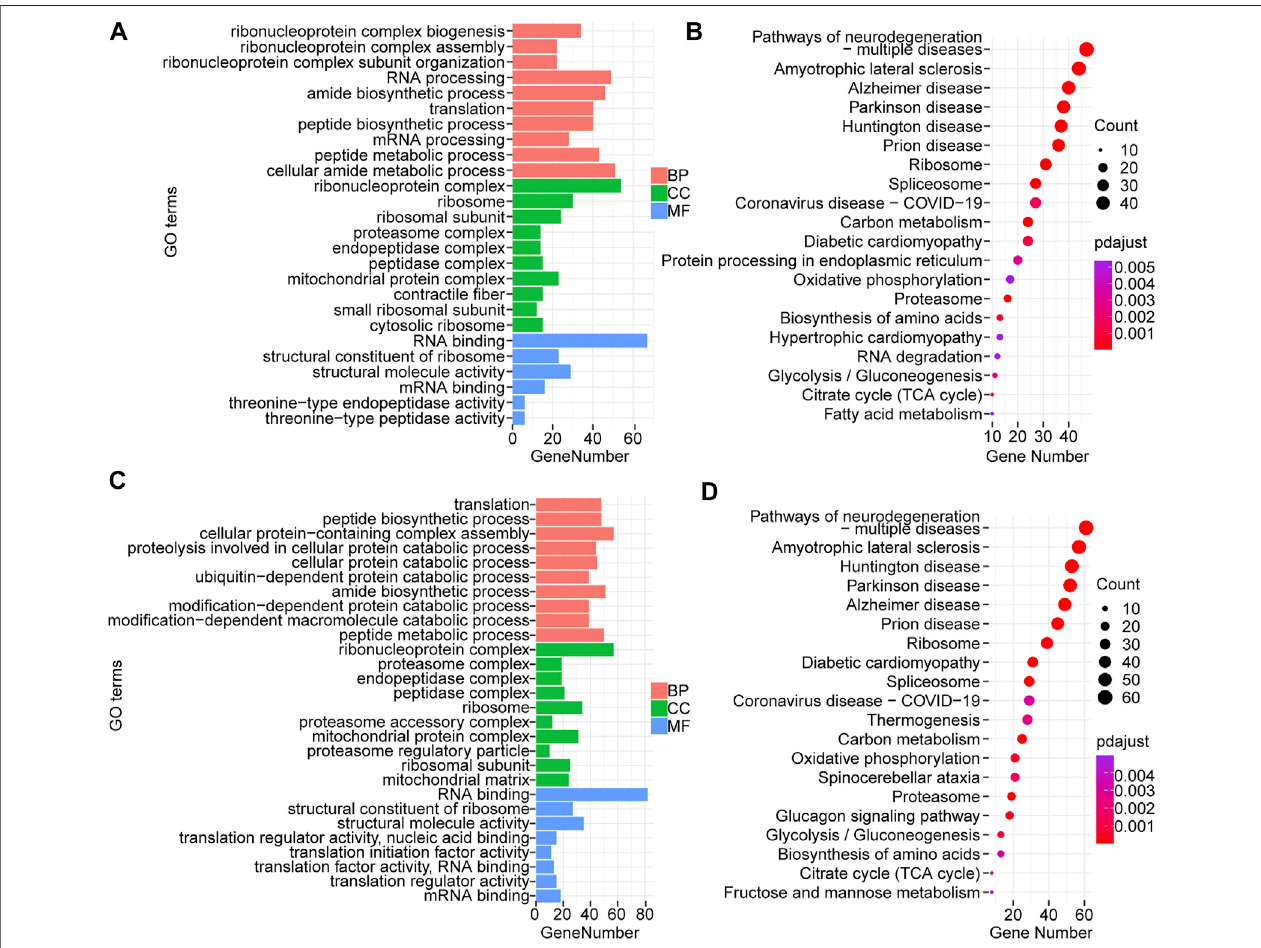
FIGURE 3 | GO and KEGG analysis of splicing isoforms speci fi cally occurring in H and L groups. (A) GO results of splicing isoforms that speci fi cally occur in high- IMFgroup; (B) KEGGresultsofsplicingisoformsthatoccurspeci fi callyinhigh-IMFgroup; (C) GOresultsofsplicingisoformsthatspeci fi callyoccurinlow-IMFgroup; (D) KEGG results of splicing isoforms that occur speci fi cally in low-IMF